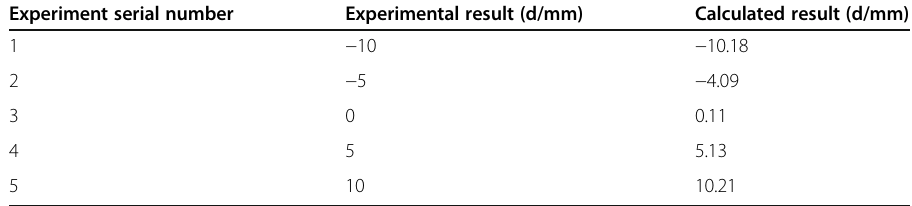
Table 3 Deviation between measured and calculated distance Experiment serial